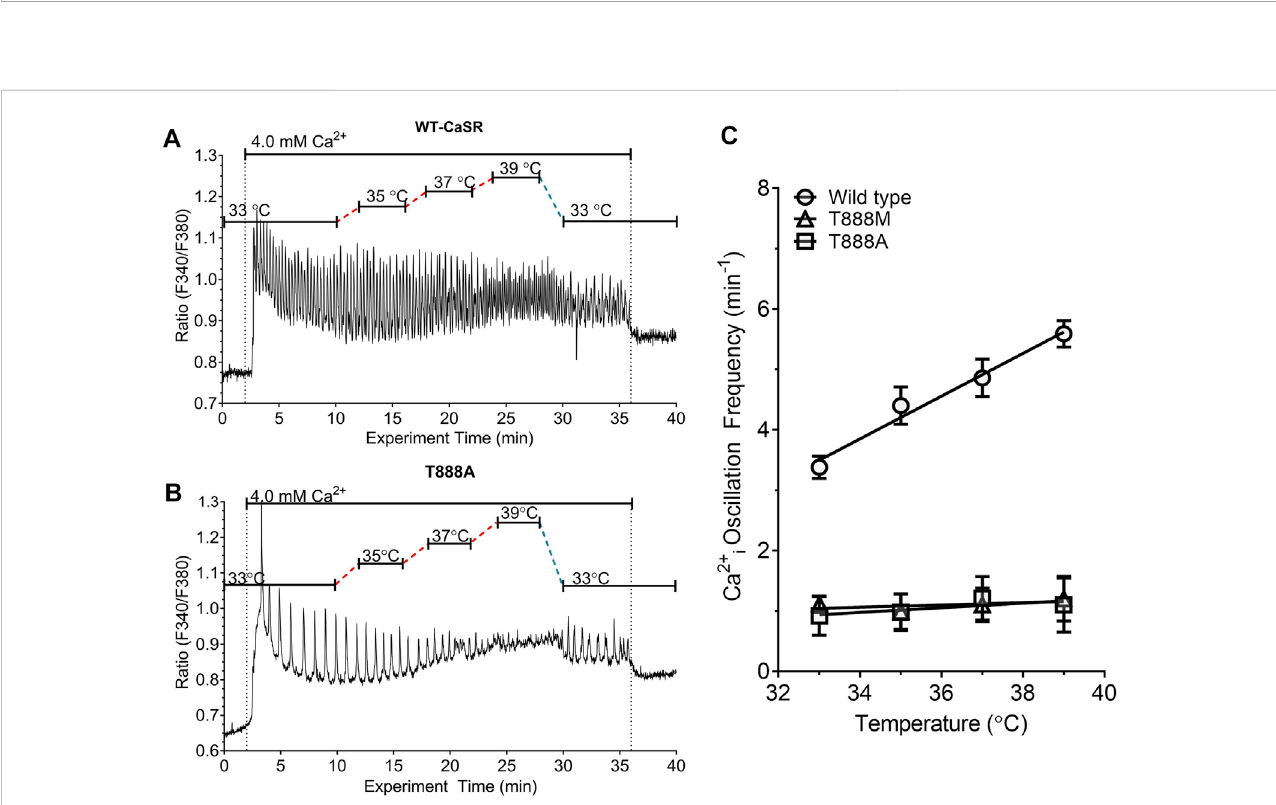
FIGURE 5 Effect of T888 mutants on temperature-dependent control of Ca 2+ o -induced Ca 2+ i oscillations in transiently transfected HEK293 cells. HEK-293 cells weretransientlytransfected for 48 hwith either theWT CaSR orCaSR mutantsT888A orT888M then loaded withfura-2AM andafter equilibrationto control Ca 2+ o (0.5 mM) exposed to 4.0 mM Ca 2+ o in a micro- fl uorescence apparatus. Temperature was adjusted as described in the Methods section. Panels (A, B) show representative traces from single cells for WT and T888A. Panel (C) shows the relationships between temperature and Ca 2+ i frequency for all